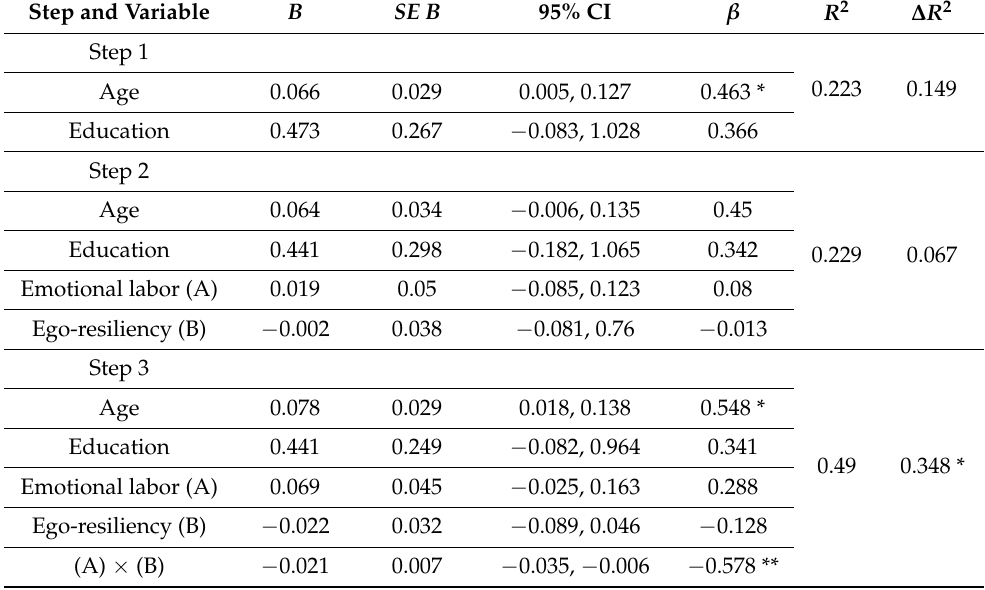
Table 4. Results of hierarchical regression analysis predicting salivary cortisol level from emotional labor with ego-resiliency as the moderator variable in the customer service group.